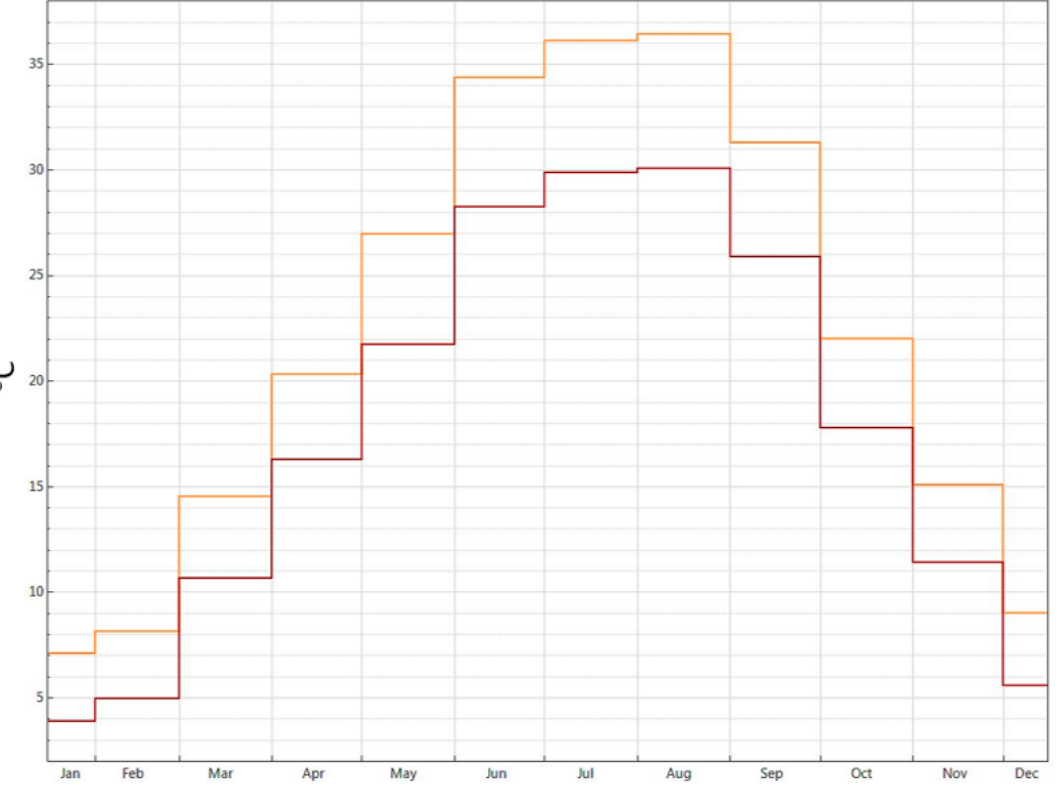
Figure 3. Dry temperature for present-day and 2080 EPW